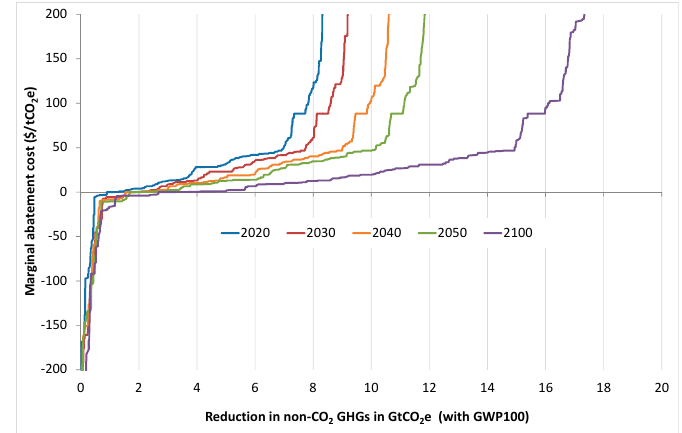
Figure 5. Time-dependent global marginal abatement cost curves for the total non-CO 2 GHGs (GWP100 basis) for 2 °C scenario with global mitigation action starting in 2020, relative to the case where indirect non-CO 2 GHG mitigation resulting from CO 2 mitigation has already occurred. Notes: Measures with a negative marginal abatement cost are assumed to be cost-saving if adopted. They are not assumed to be taken up in the reference scenario, as a result of uncertainty, inertia and inefficiency in current practices.